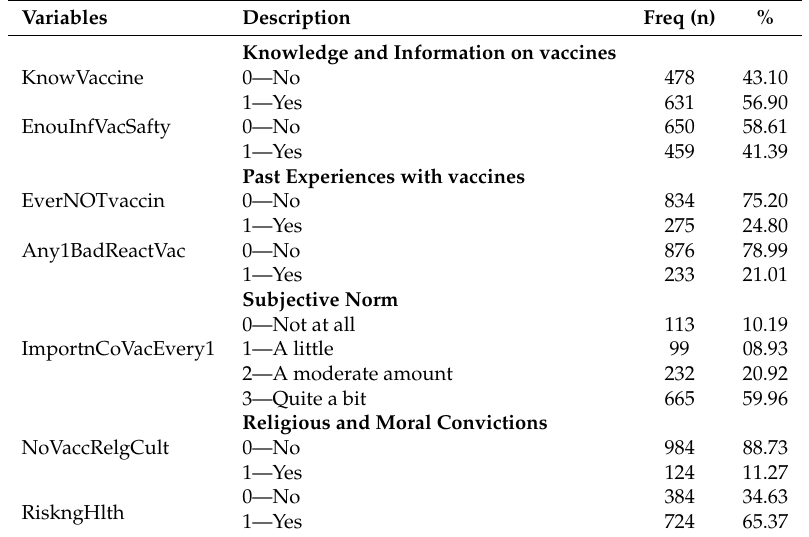
Table A3. Personal and Peer Influences on individual perceived COVID-19 vaccine utility (n = 1109).